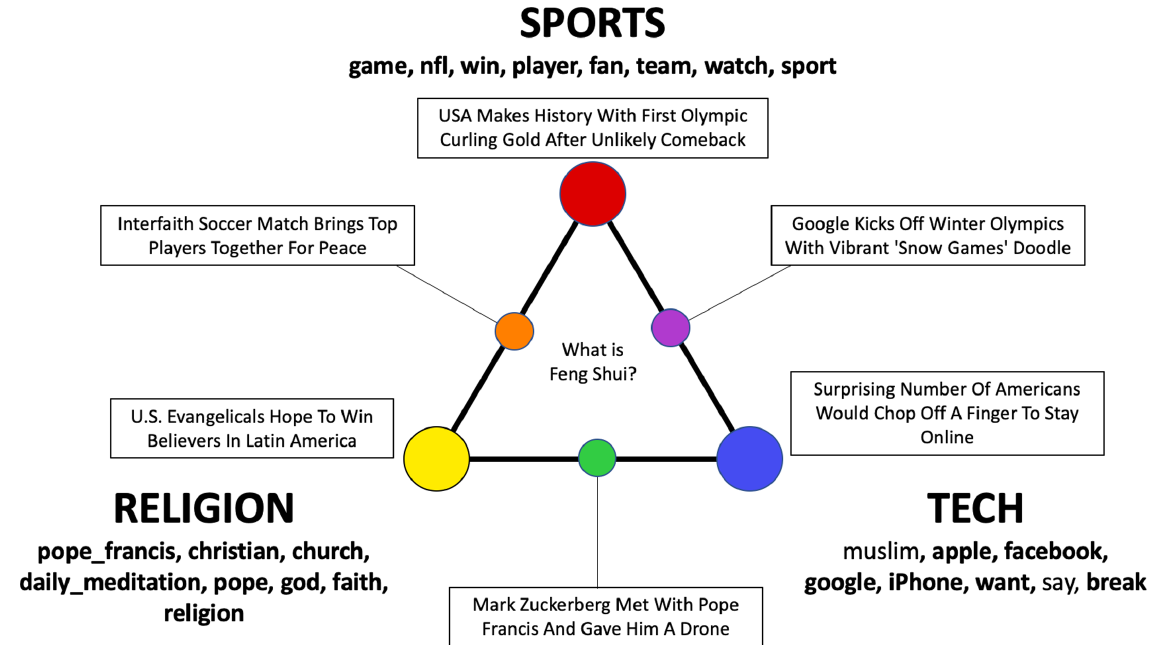
FIG. 1. Example results from an LDA model trained on a dataset of roughly 9000 Huffington Post headlines from 2012 – 2018